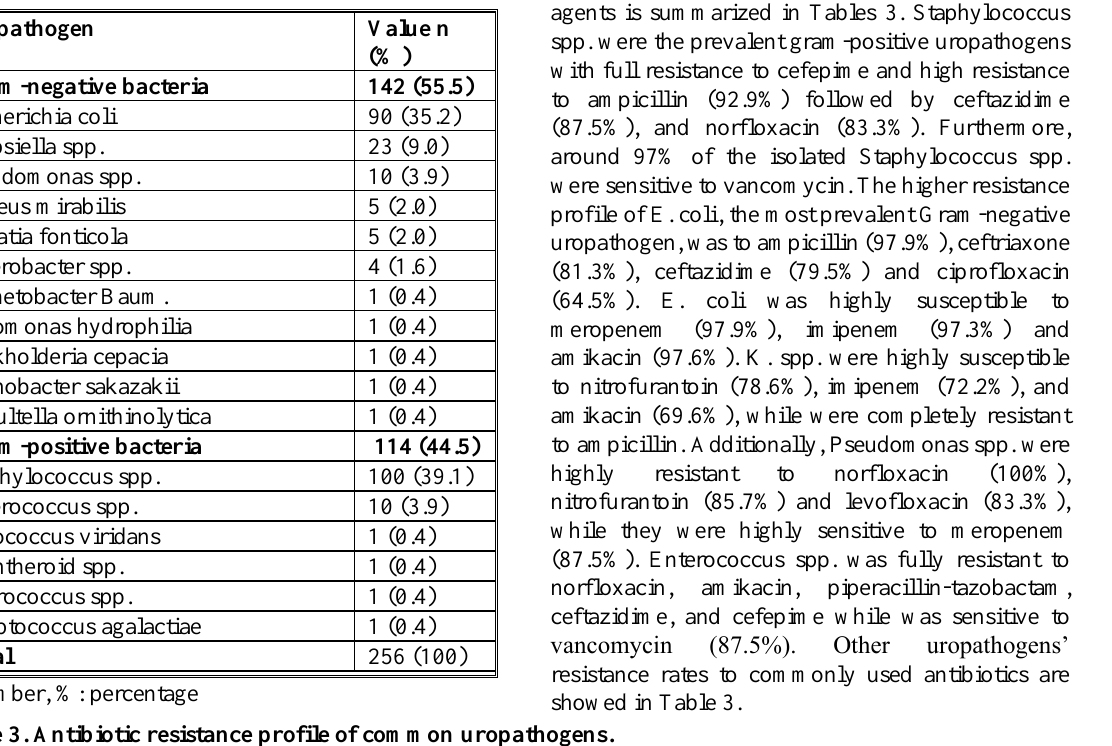
Table 2. Prevalence of uropathogens detected in the isolates (n= 256)